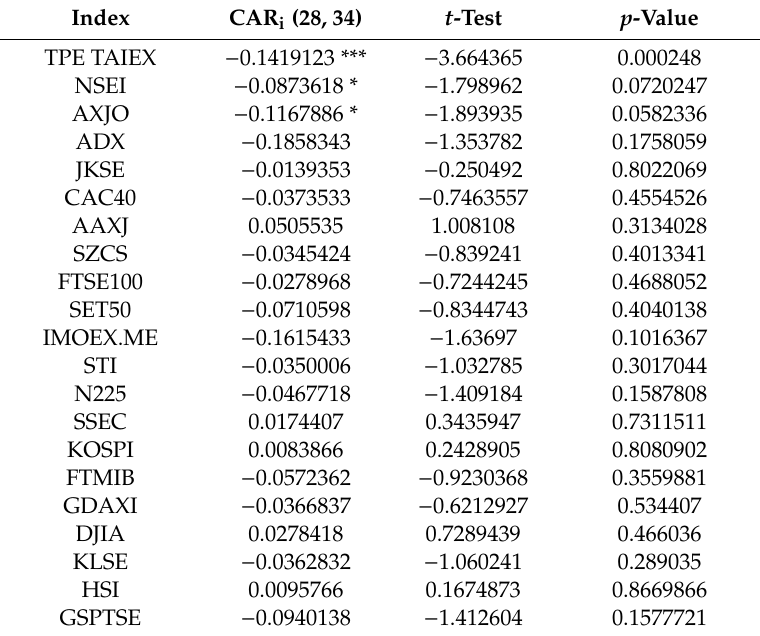
Table 9. Cumulative abnormal return in the event window (28,